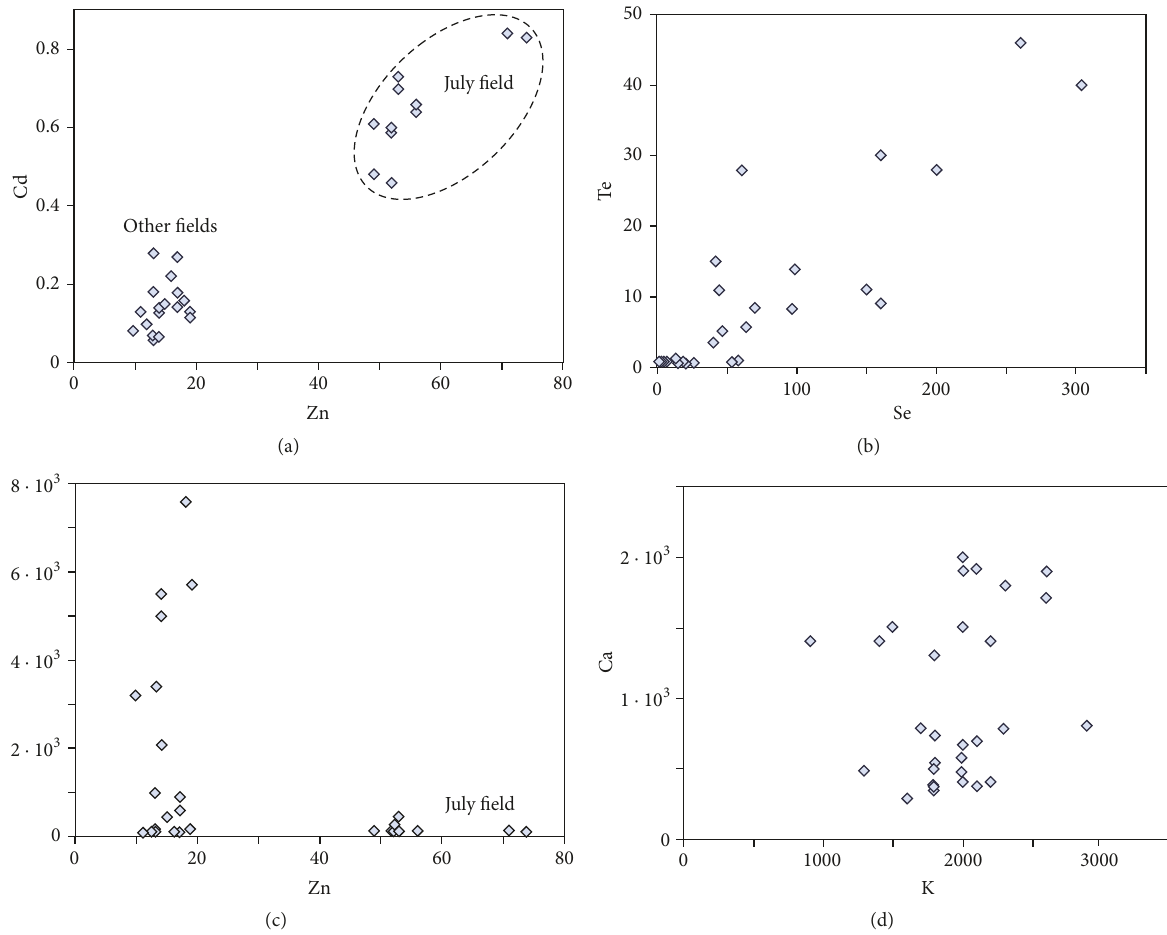
Figure 4: Variation diagrams for elements with different behaviors. (a) The chalcophile elements of Zn and Cd are moderately correlated between each other and have distinctly different concentrations in the July field (high) and in other fields (low). (b) The chalcophile elements of Se and Te are moderately correlated but exhibit no dependence on fumarolic fields. (c) Iron is not correlated with the chalcophile element Zn but has high concentrations in only one field. (d) The lithophile elements of K and Ca are not correlated.